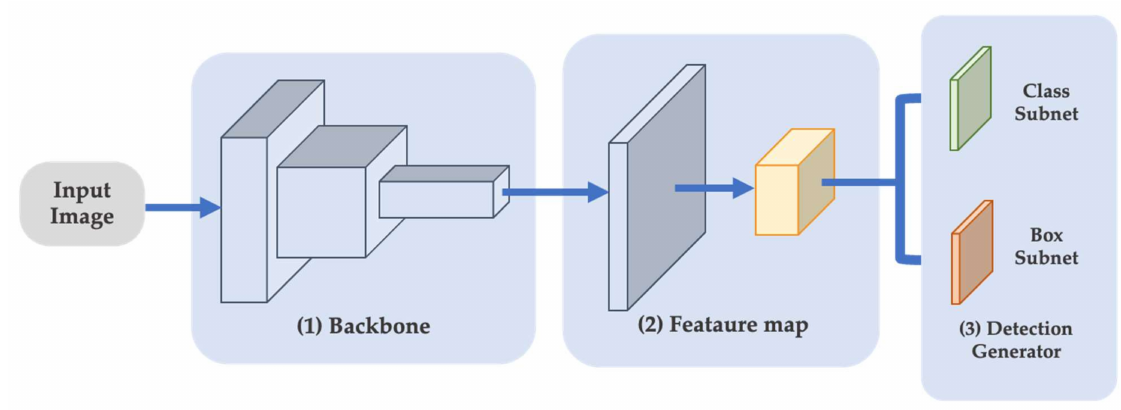
Figure 1. One-stage object detection architecture.